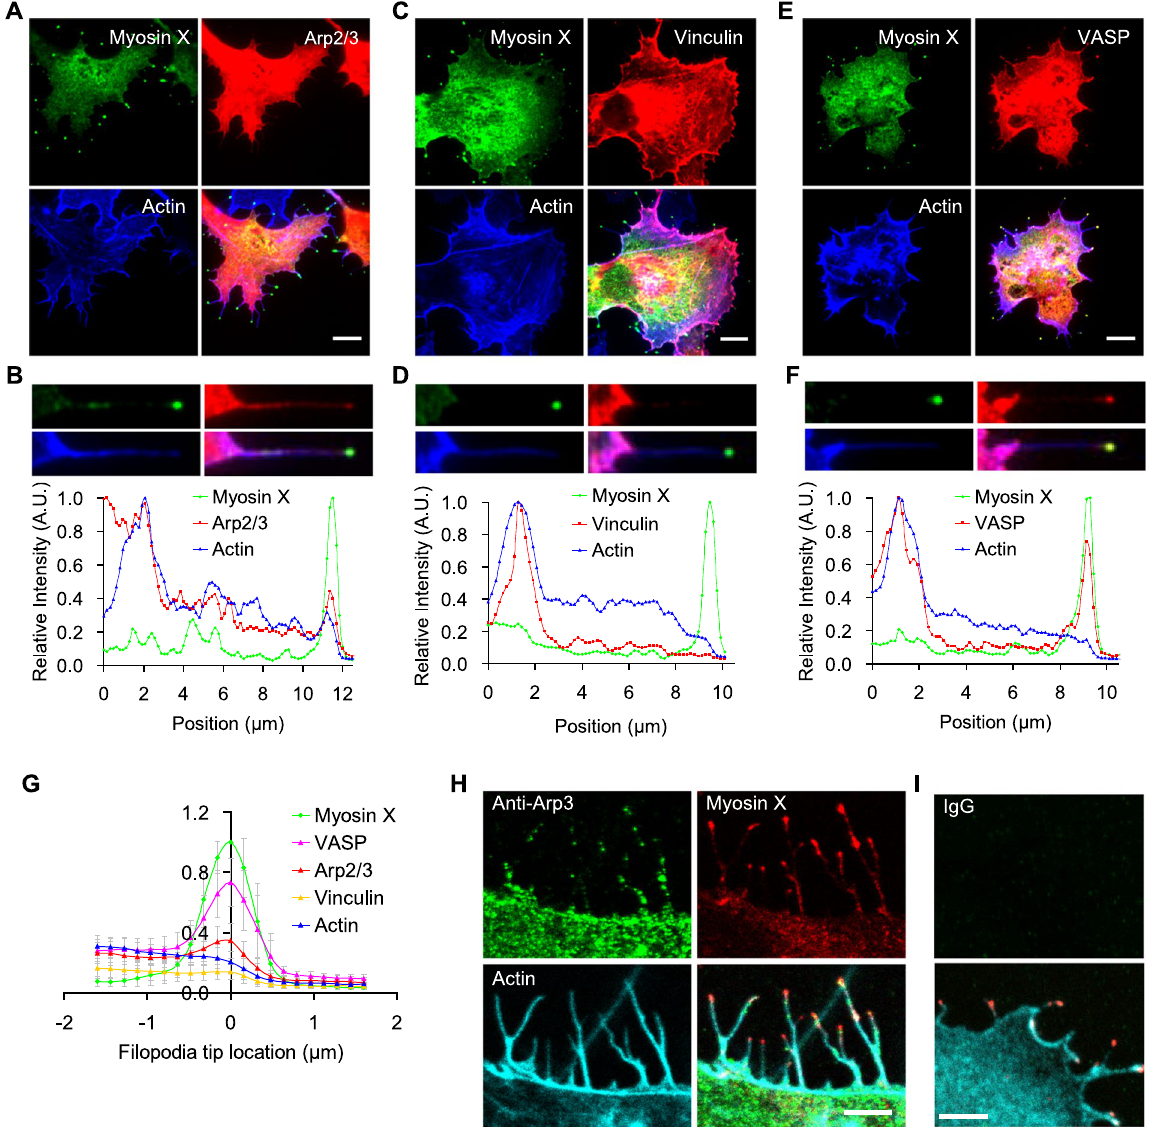
Figure 1. Spatial distribution of myosin X, actin, Arp2/3, vinculin and VASP along myosin X-induced filopodia. COS7 cells were co-transfected with EGFP-myosin X and mCherry-Arp2/3 ( A ), EGFP-myosin X and vinculin-tomato ( C ), or EGFP-myosin X and mCherry-VASP ( E ), and then stained with Alexa Fluor 633-conjugated phalloidin to label actin structures. The cells were imaged using triple-color TIRFM. ( B , D and F ) The enlarged representative filopodia and the normalized fluorescence intensities of the indicated proteins along filopodia were shown. A small fraction of myosin X was undergoing active intrafilopodial movement toward filopodial tips, which is reflected by the local variation of the intensity traces. The intensity variation depends on the relative amount/number of intrafilopodial EGFP-myosin X in different filopodia. Scale bars, 10 μ m. ( G ) Referring to the fluorescence center of EGFP-myosin X at filopodial tips, the normalized fluorescence traces of EGFP-myosin X (n = 17), vinculin-tomato (n = 22), mCherry-Arp2/3 (n = 17), mCherry- VASP (n = 12) and actin (n = 18) from 4–8 cells were aligned, averaged and then overlaid, respectively. ( H ) Localization of endogenous Arp2/3 in myosin X-induced filopodia. The mCherry-myosin X expressing cells were stained with anti-Arp3 antibody followed by Alexa-Fluor 488-conjugated secondary antibody. Actin was stained with Alexa Fluor 633-conjugated phalloidin. ( I ) To show the specificity of Arp2/3 staining, the mCherry-myosin X expressing cells were stained with non-immune IgG (the same concentration as anti-Arp3) followed by Alexa-Fluor 488-conjugated secondary antibody. The upper panel shows the staining of the IgG channel. The lower panel is the merged image of mCherry-myosin X and actin. Scale bars, 5 μ